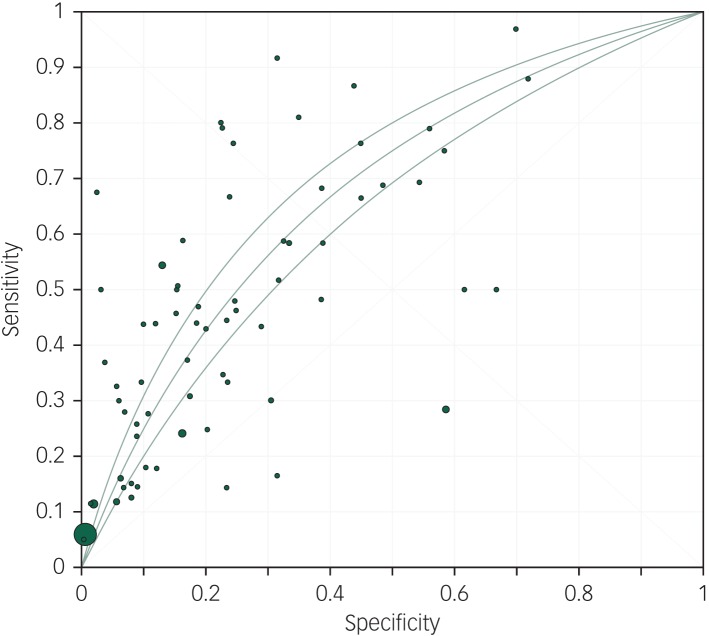
Meta-analytic area under the curve.